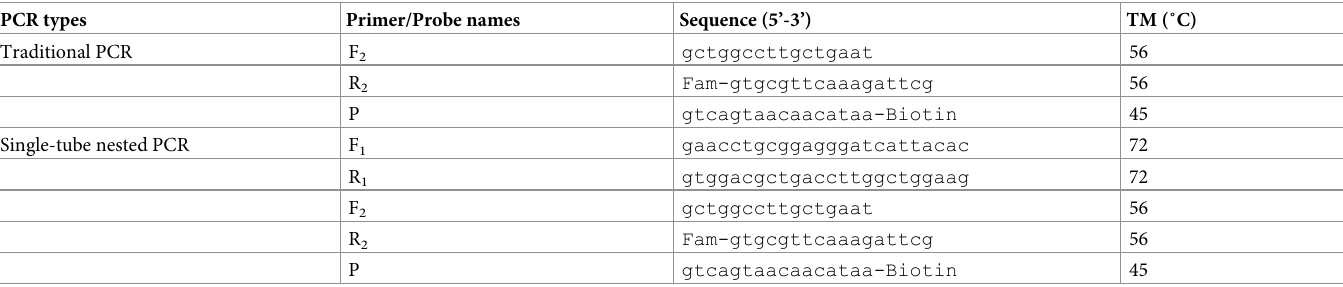
Table 1. Primers and